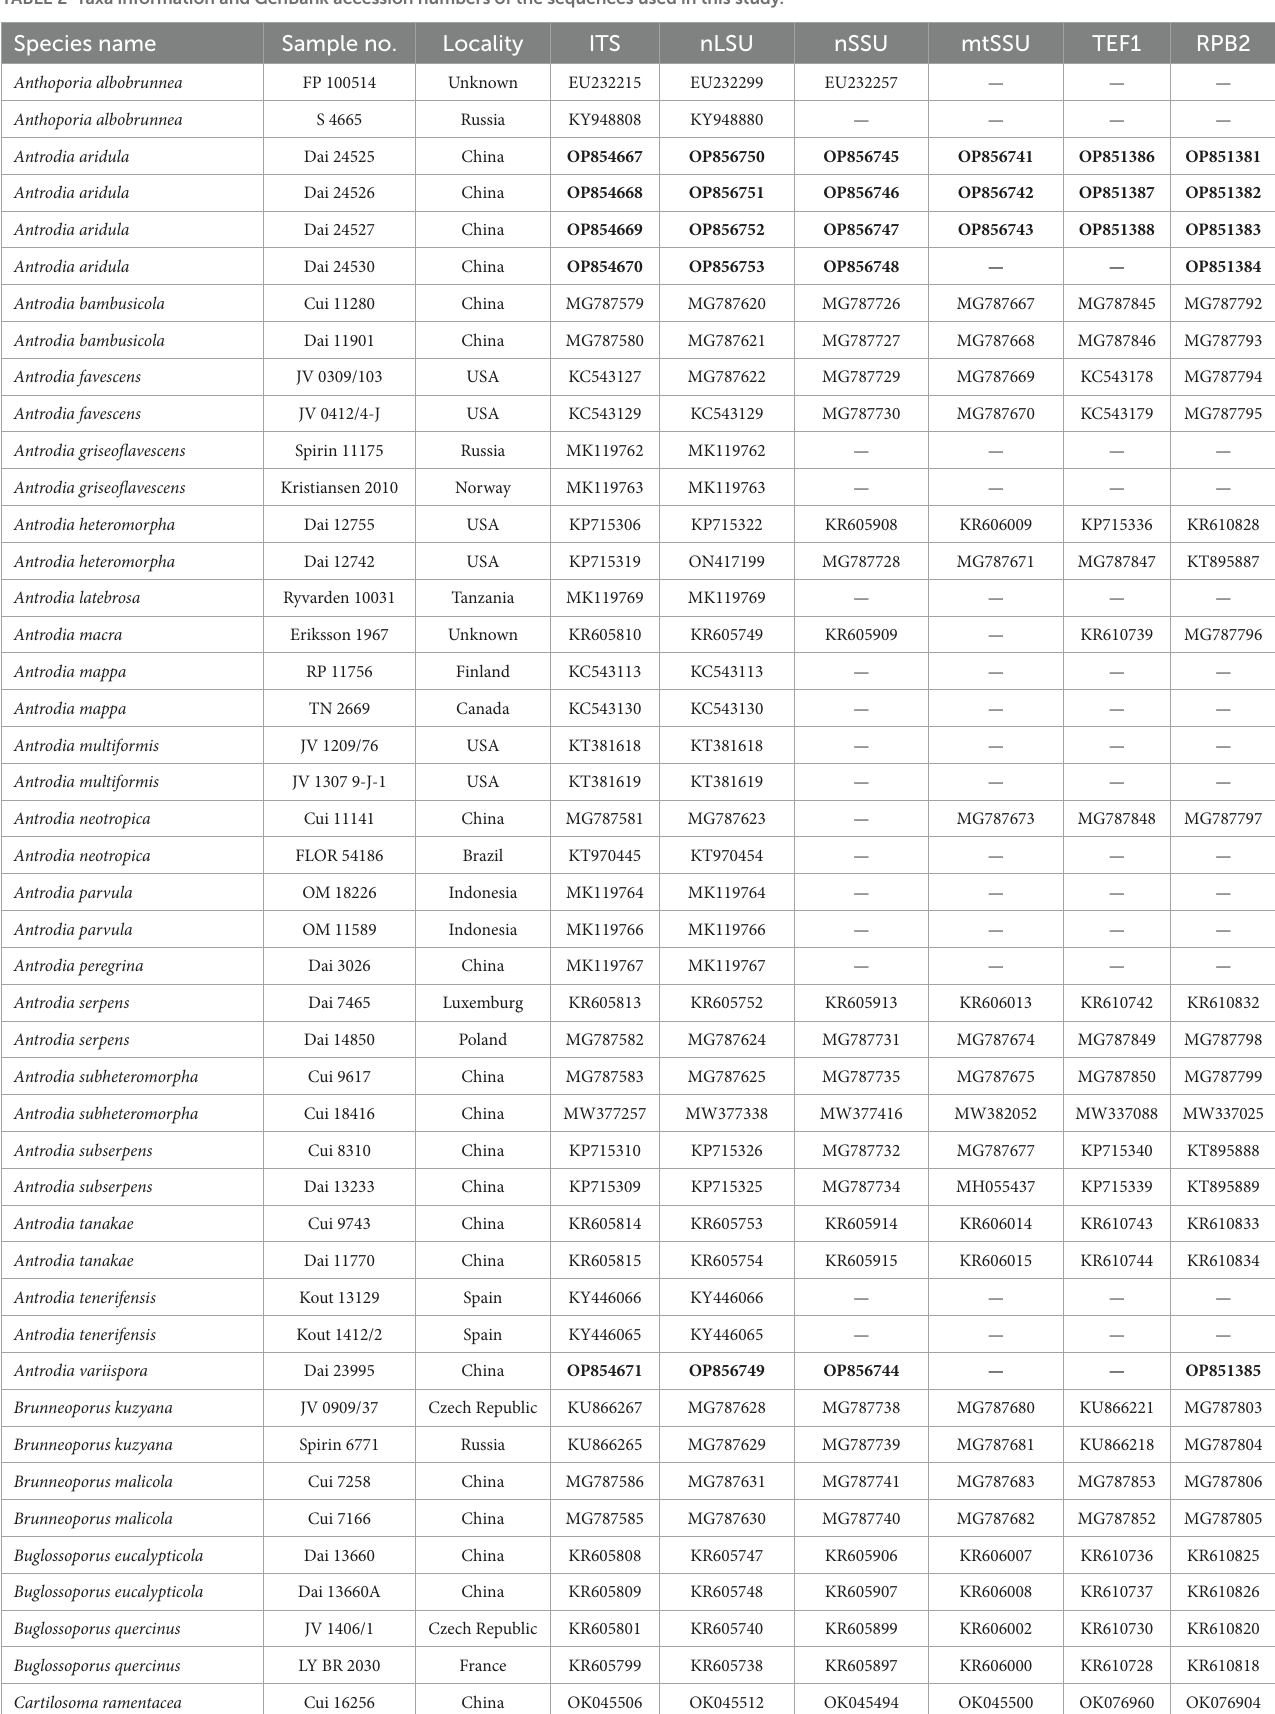
TABLE 2 Taxa information and GenBank accession numbers of the sequences used in this